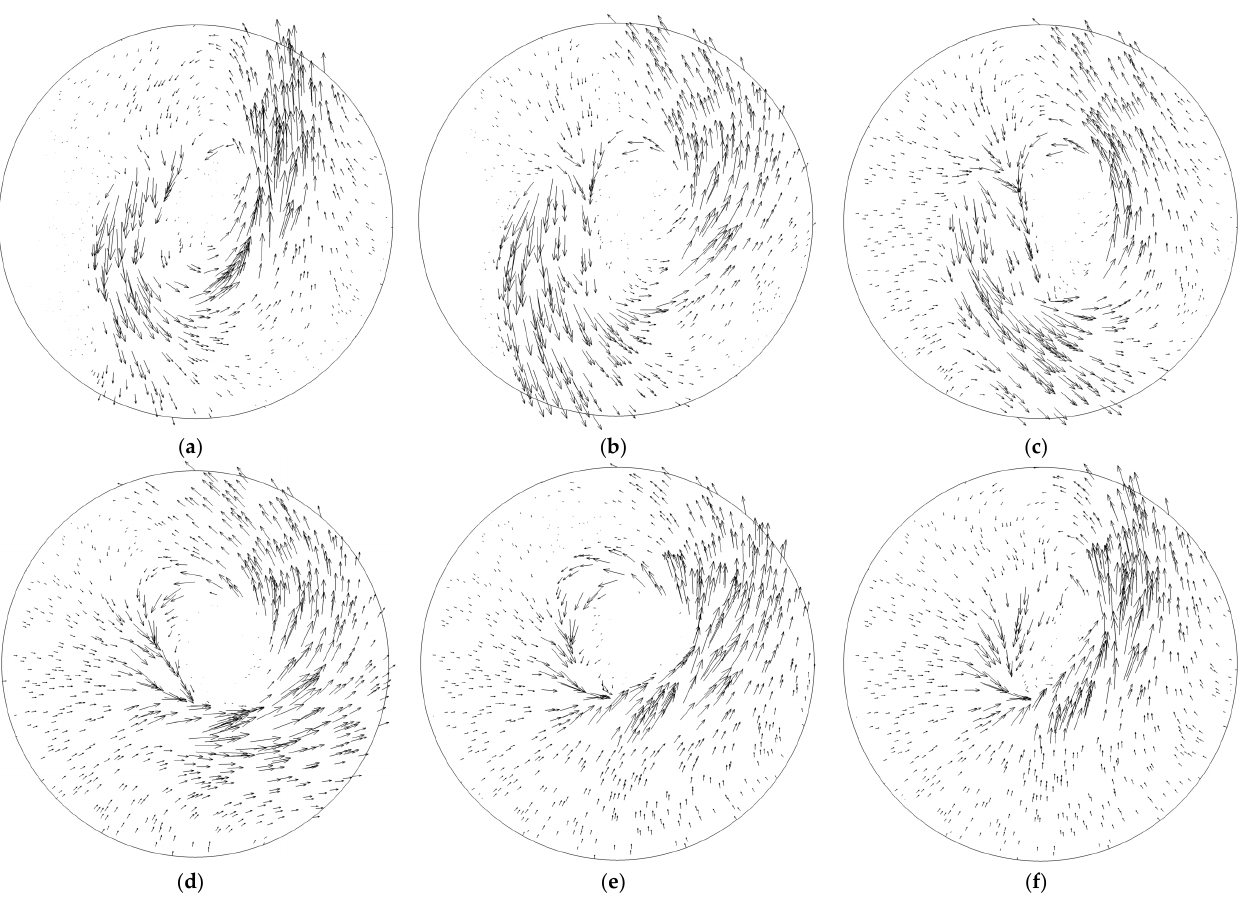
Figure 14. When inlet pressure = 15 MPa, gap = 1.5 mm, the variation of the velocity vector of the original suction cup with time in adhesion interface plane at: ( a ) 5 ms, ( b ) 9.4 ms, ( c ) 13.8 ms, ( d ) 18.2 ms, ( e ) 22.6 ms, and ( f ) 27 ms.